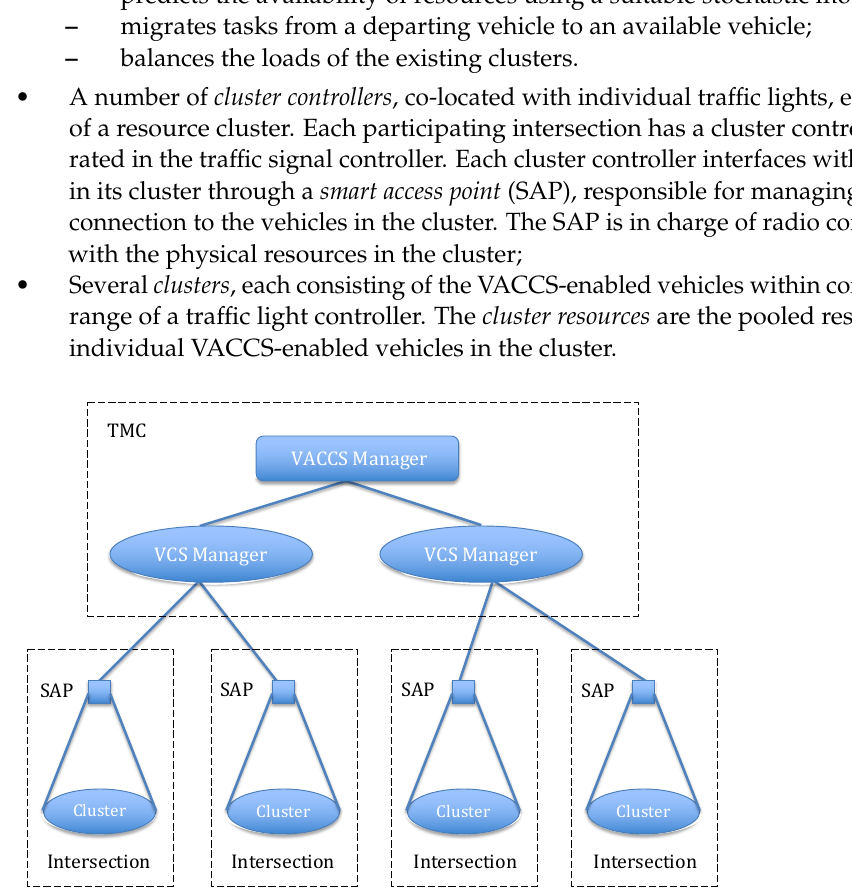
Figure 1. A high-level view of the VACCS